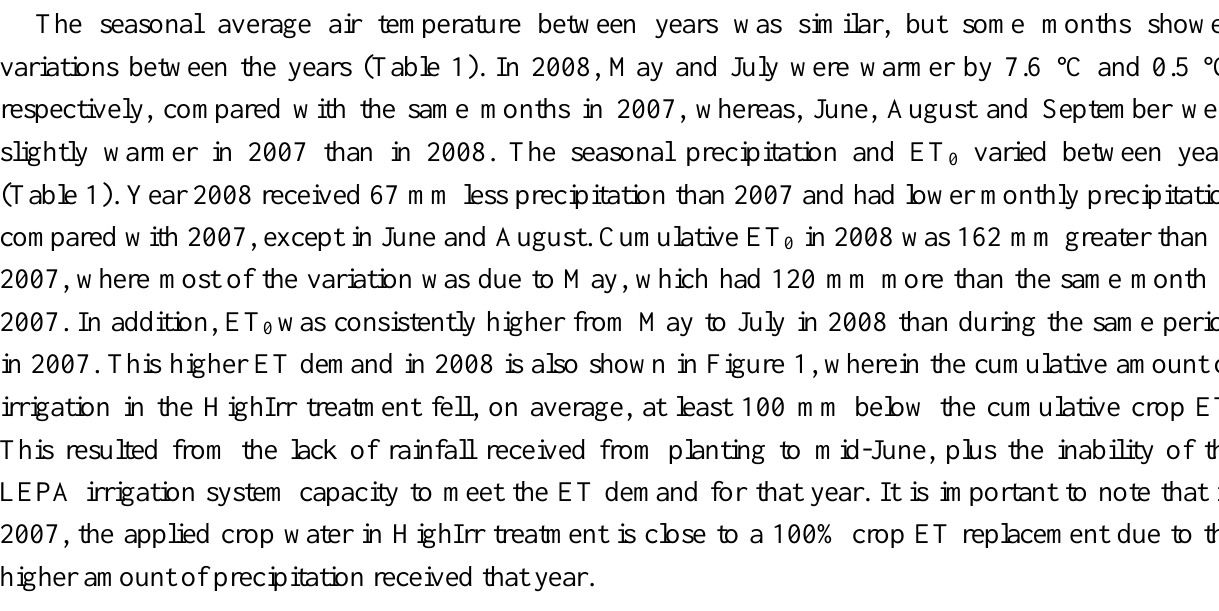
from the Texas High 0